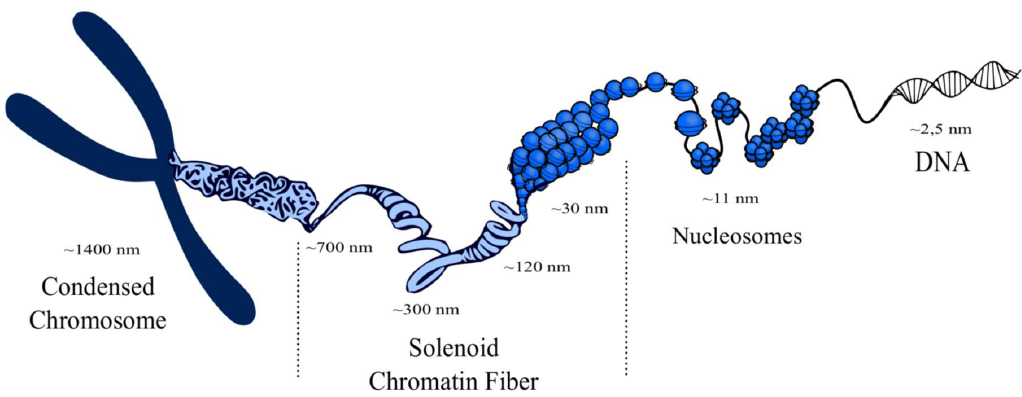
Figure 1. Visualization of a chromosome structure. Histone octamers with DNA are compressed in nucleosomes, which in turn form chromatin fibers called solenoids. Solenoids form the structure of a chromosome, which is located in the nucleus [10–13].